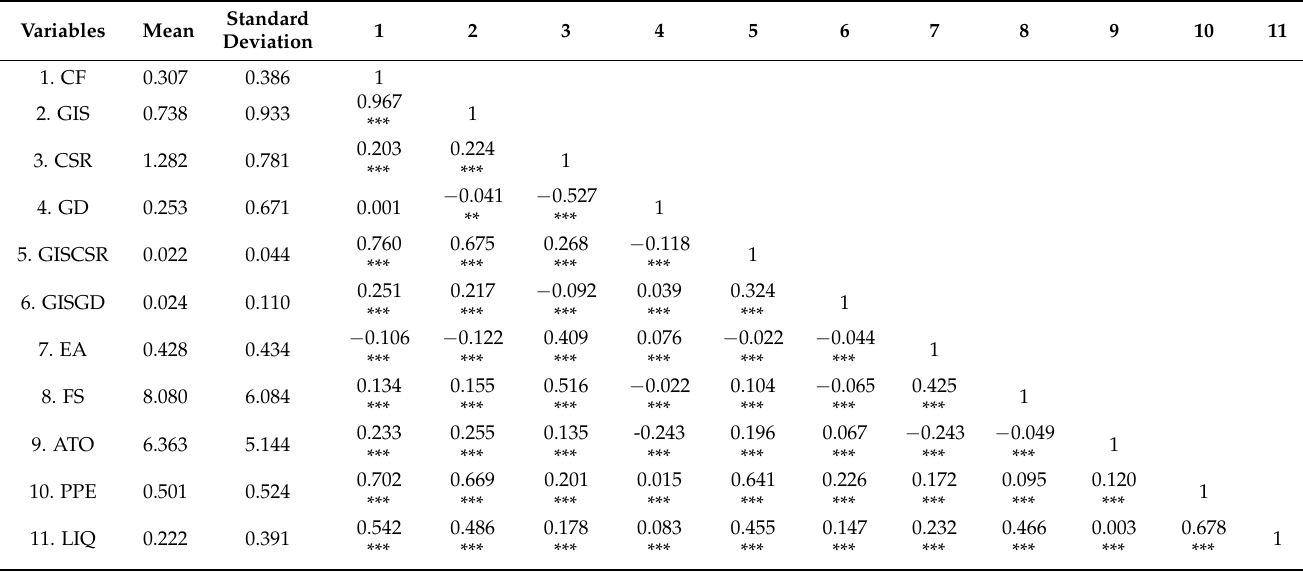
Table 1. Descriptive statistics and Pearson